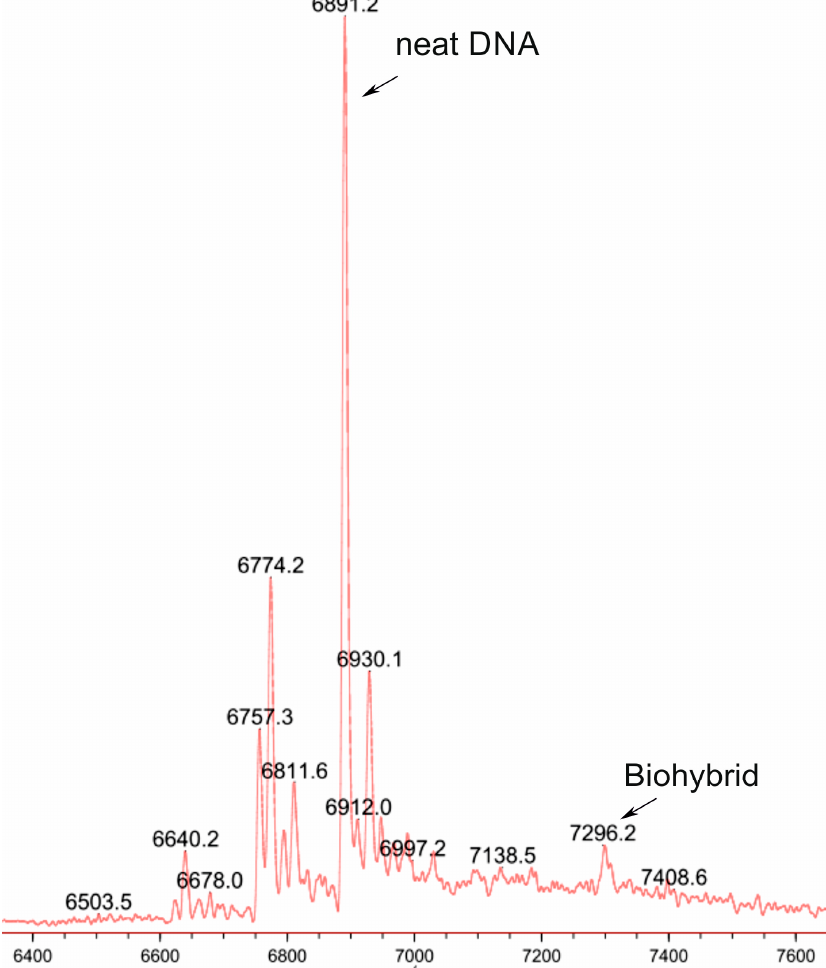
Figure 4 Figure 5. The part of the MALDI-ToF mass spectrum of lyophilized ML showing a neat DNA decamer ( m / z = 6891.2) and an alkylated biohybrid with compound 1 ( m / z = 7296.2).